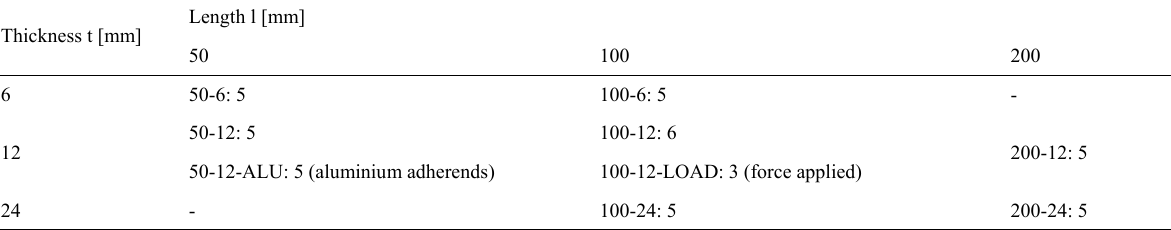
Table 1: Investigated parameters, designation and number of specimen